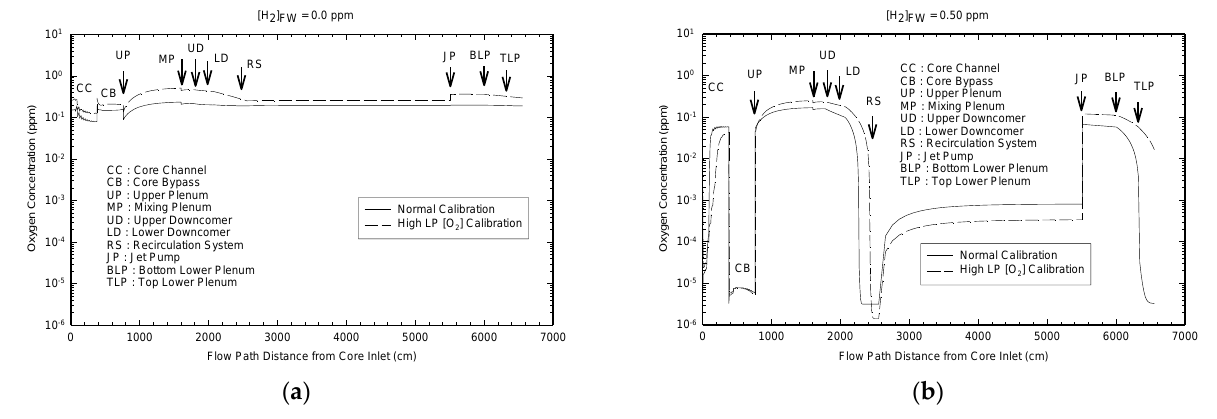
Figure 13. Calculated [O 2 ] around a BWR PHTS for ( a ) NWC and ( b ) HWC with [H 2 ] FW = 0.5 ppm. Note that two calibrations are included: the normal calibration on [O 2 ] in the autoclave valved into the recirculation system and calibration of the [O 2 ] measured in the LP.